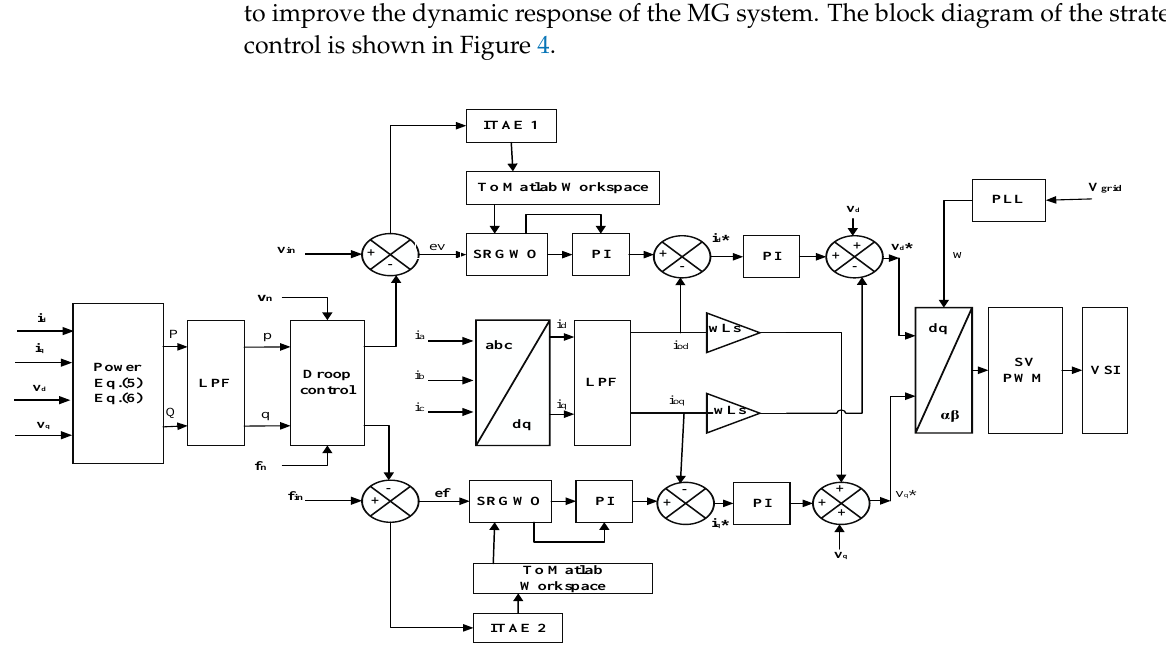
Figure 4. Block diagram of control strategy.